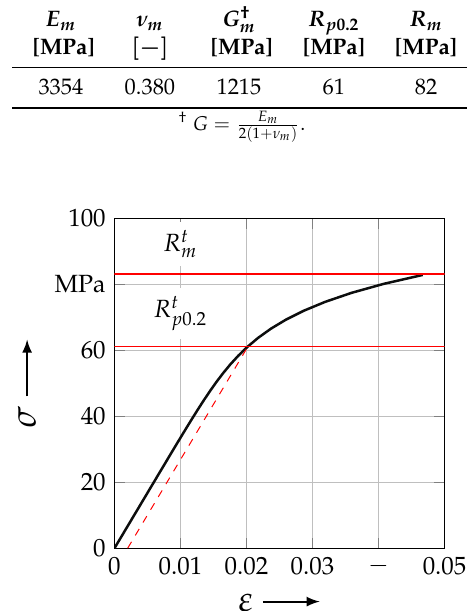
Figure 15. Underlying elastic–plastic stress–strain curve of RTM6-2 for numerical computation.